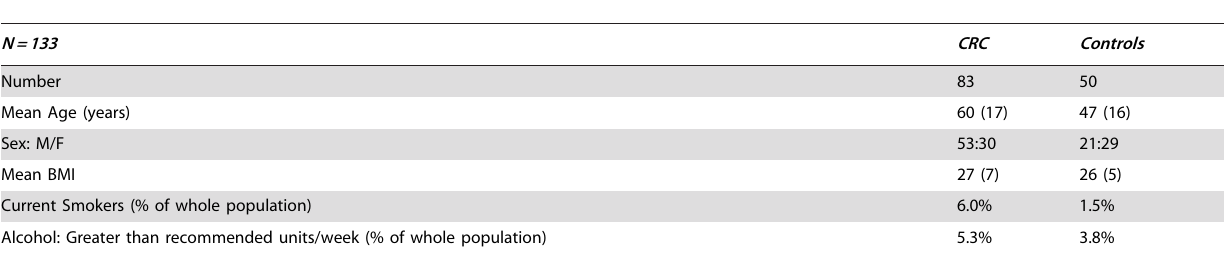
Table 1. Demographic data for CRC and control patients.